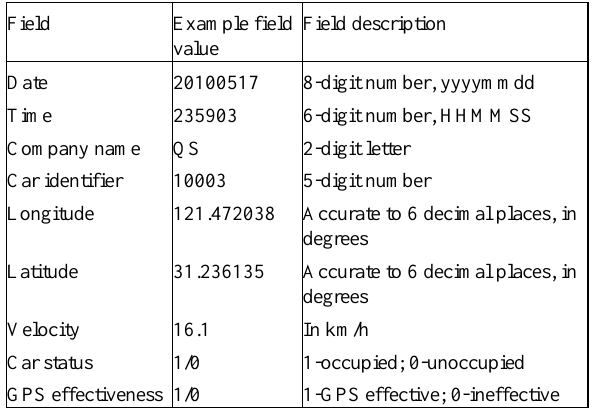
Table 3. Description of the fields of floating car